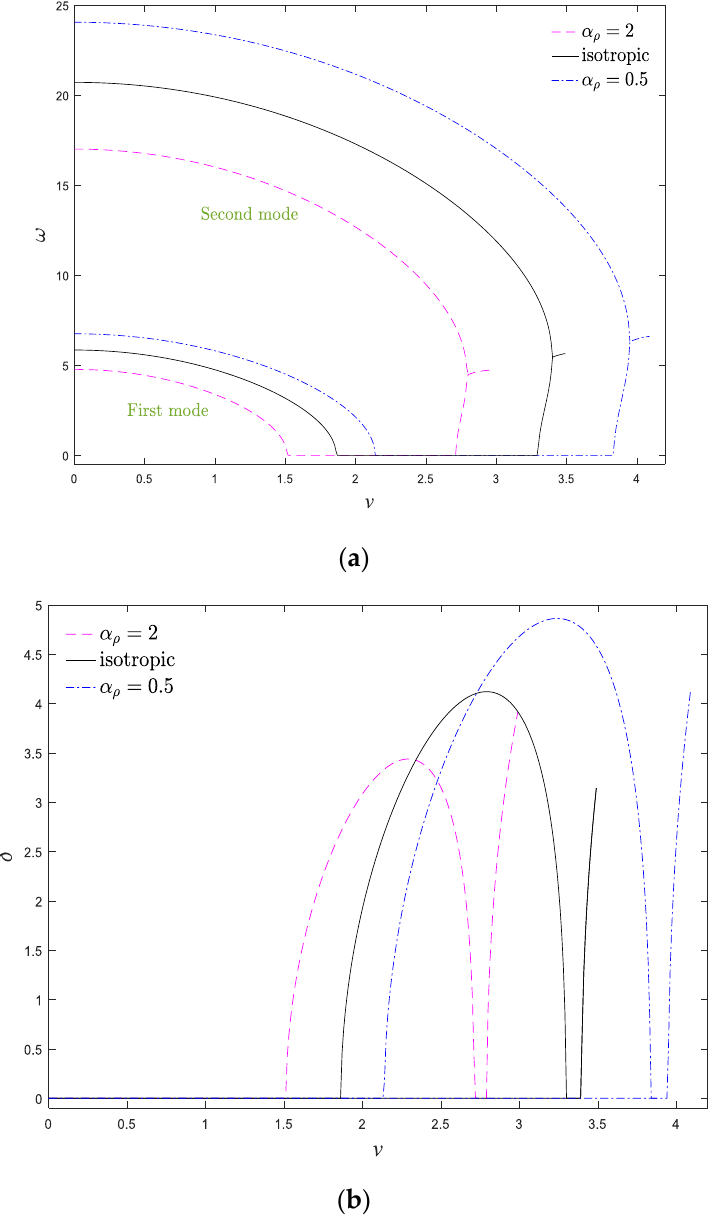
Figure 9. ( a ) Real and ( b ) imaginary parts of two first natural frequency of the system against the dimensionless axial velocity for ζ = 0, α E = 1, k f = 0.5, µ = 0, k = 1.